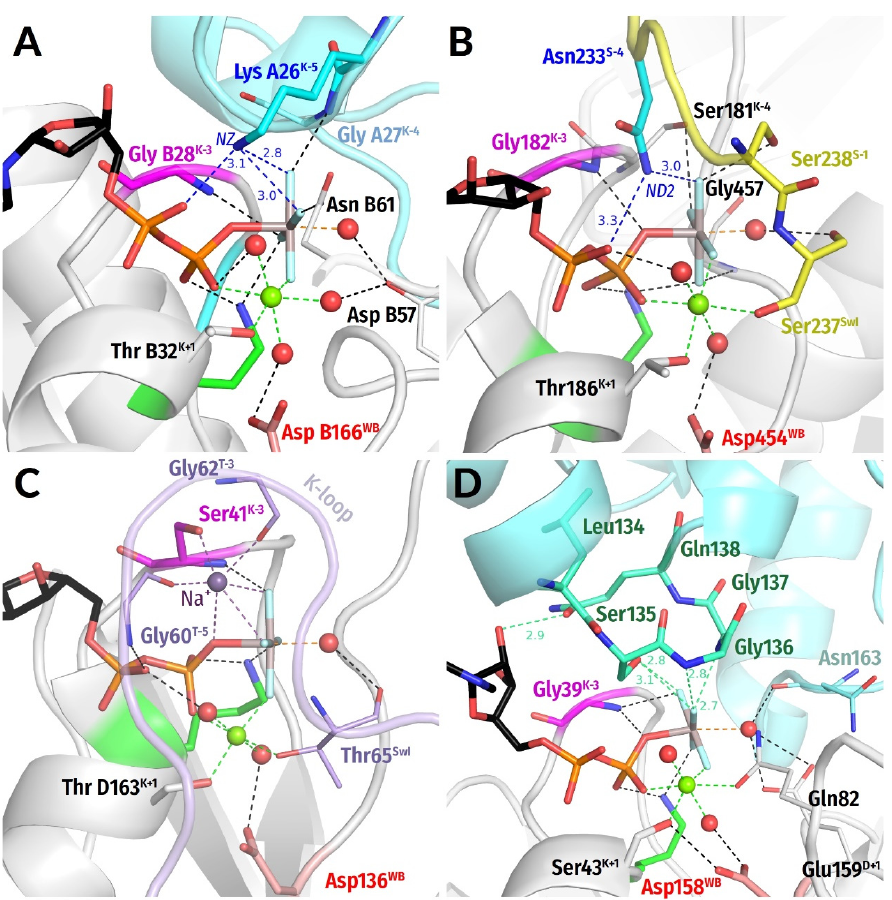
Figure 8. Examples of stimulatory interactions involving moieties other than arginine residues as stimulators. The colour code as in Figure 1C,D and Figure 7. ( A ) Interaction of a Lys finger, as provided by another subunit of the homodimer, with α - and γ -phosphates; the structure of ATPase GET3, (PDB 2WOJ, chain B [106]) is shown. ( B ) Asn finger in myosin II from Dictyostelium discoideum (PDB 1W9J). The Asn S − 4 finger is provided by the Switch I motif, which is shown in yellow. ( C ) A Na + ion as a stimulator in dynamin, (PDB 2X2E [107]). The switch I/K-loop motif is shown in lilac. Notably, the Gly residue coordinating Na + is also contacting the O 2A atom of GDP. ( D ) The LSGGQ motif in a structure of ABC-ATPase MBP-maltose transporter MalK (PDB 3PUW, chain A [100]). While Ser and Gly residues are coordinating γ -phosphate via the backbone HN atom and the OG atom of the conserved serine residue, the Gln residue is contacting the O2 (cid:48) atom of the ribose moiety in GDP